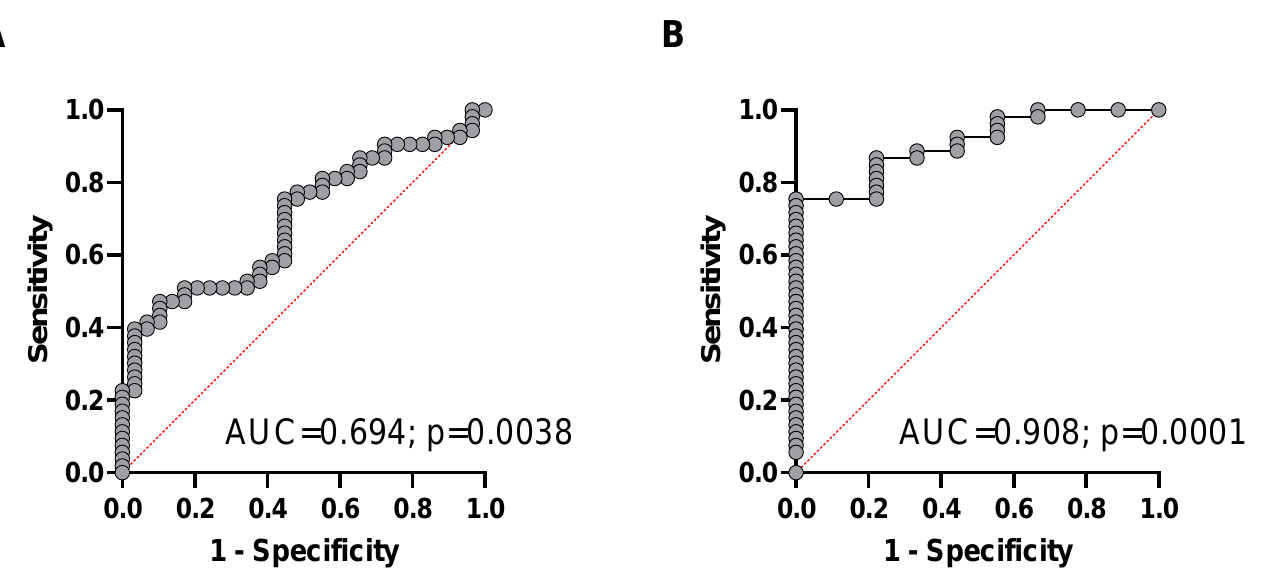
Figure 4. Multiparametric ROC analysis using plasma cfDNA concentration, percentage of cfDNA hypomethylation, and cfDNA integrity to estimate the strength of the model to discriminate between ( A ) healthy controls and NEN patients with advanced disease or between ( B ) presumably cured NEN patients and patients with advanced NEN disease.